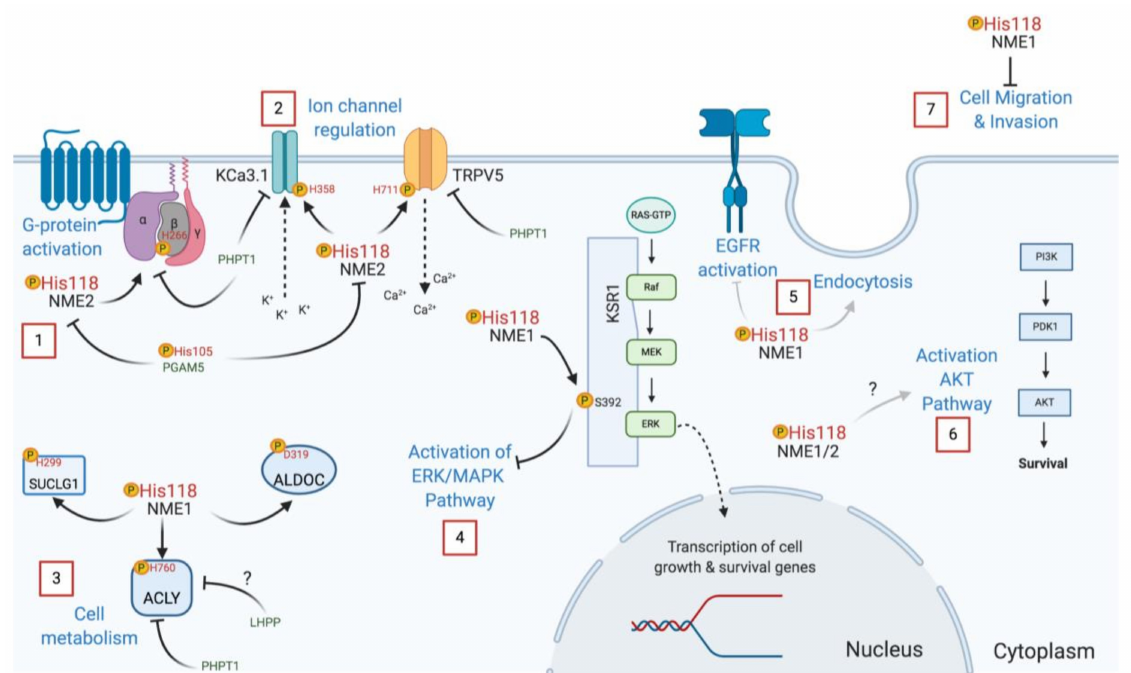
Figure 5. NME protein-histidine kinase functions. 1. NME regulates G-protein activation through histidine phosphorylation of the G-protein beta subunit 1 (H266). 2. NME modulates ion